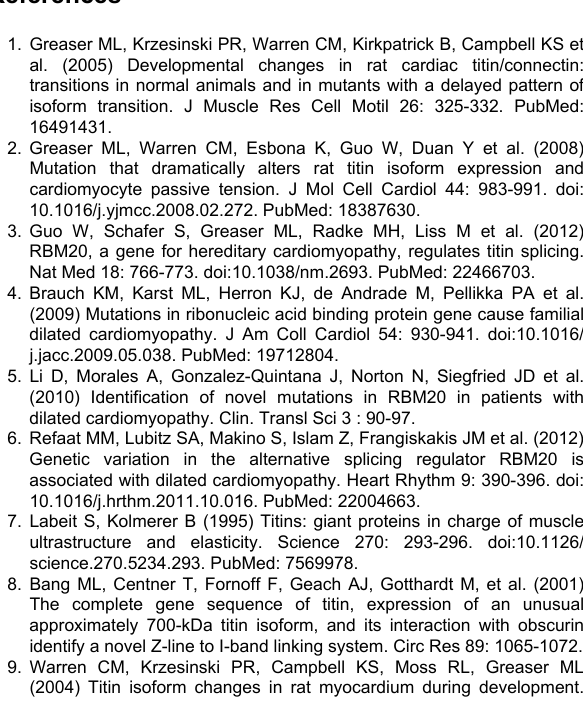
Table S2. Animal phenotype data. Sex and age paired animals were used for the running protocol. F: Female; M: Male; Wt: Wild type; Hm: Homozygote mutant.